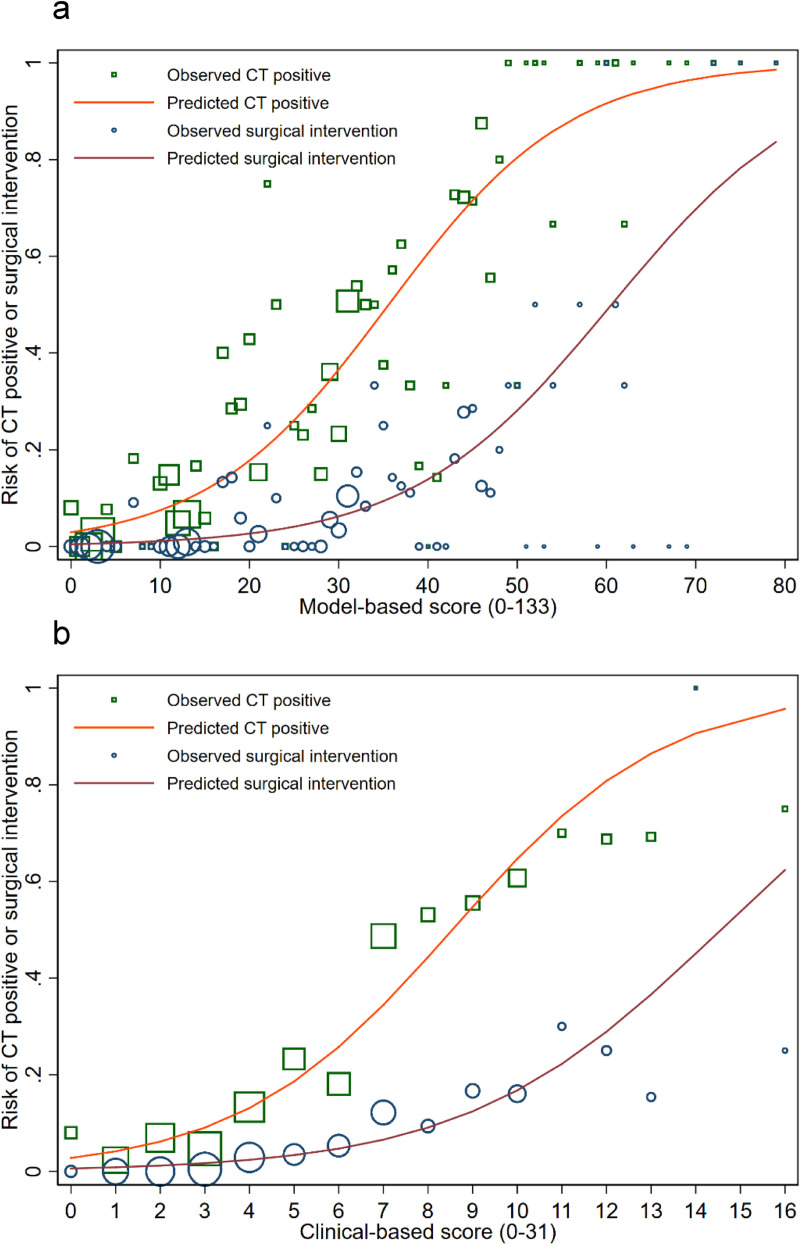
Calibration plots visualizing agreement between both the model-based scoring system (3a), the clinical-based scoring system (3b) and the observed risk of positive CT findings or the risk or neurosurgical intervention. The orange line depicts the predicted risk of positive CT findings. The green square represents the observed risk of positive CT findings. The red line depicts the predicted risk of requiring neurosurgical intervention. The blue circle represents the observed risk of requiring neurosurgical intervention.